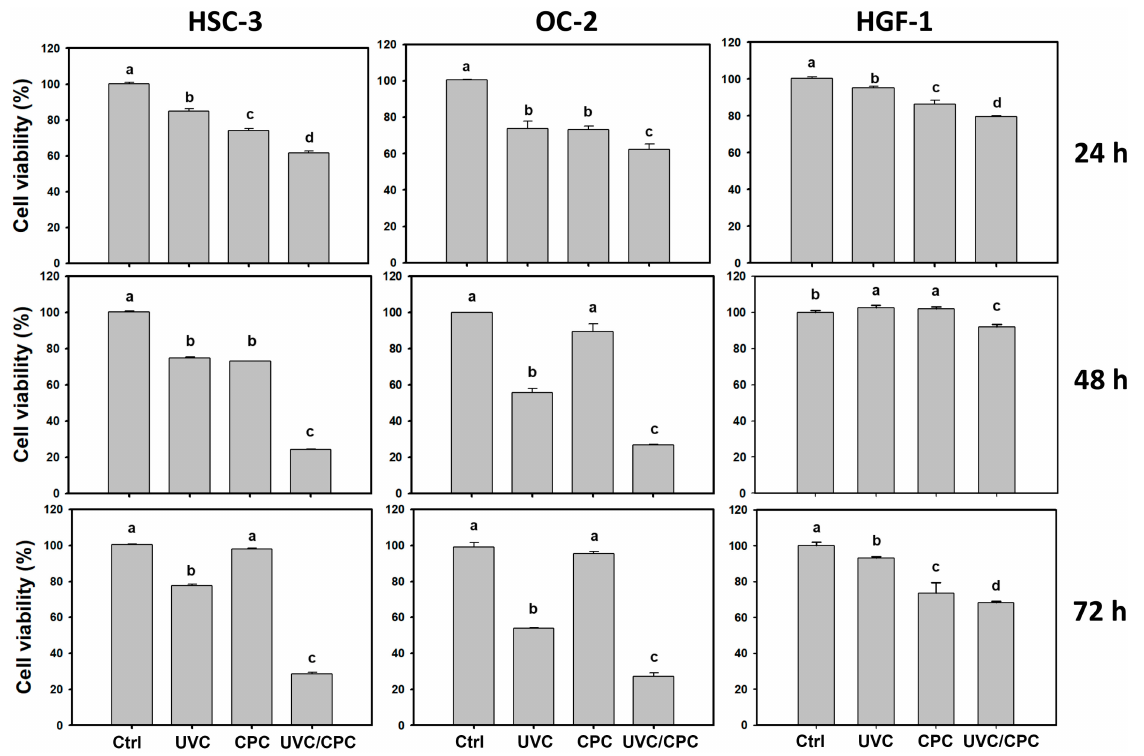
Figure 1. Cell viability change of oral cancer and normal oral cells following UVC or/and CPC treatments. Oral cancer (HSC-3 and OC-2) and normal oral (HGF-1) cells were arranged to treat with vehicle control, UVC (10 J/m 2 ), CPC (5 µ g/mL), and UVC/CPC (10 J/m 2 and 5 µ g/mL). A 24, 48, and 72 h MTS assay measured cell viability. Based on multiple comparisons after Tukey’s HSD Tests, different tests labeled with different top letters differed significantly ( p < 0.05). Data is presented as means ± SD ( n = 3). For example, OC-2 cells at 24 h MTS, UVC and CPC showing “b, b” with the overlapping letter ”b” indicated a non-significant difference between each other. Control, UVC, and UVC/CPC in OC-2 cells showing “a, b, c” without overlapping letters indicated a significant difference between each